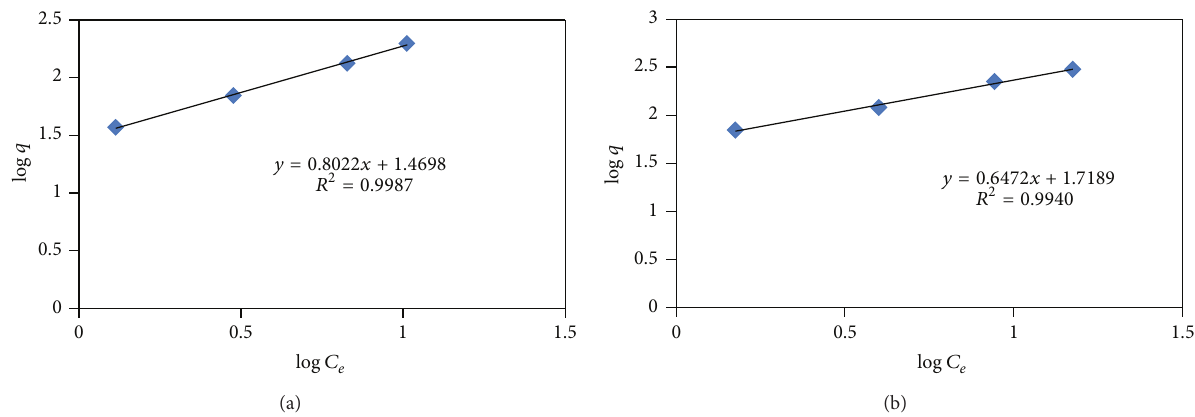
Figure 12: (a) Freundlich isotherm of basic orange dye adsorption onto CNTs (pH = 8.5, CNTs = 100 mg/L, contact time = 30min). (b) Freundlich isotherm of methyl violet dye adsorption onto CNTs (pH = 8.5, CNTs = 50mg/L, contact time = 40 min).